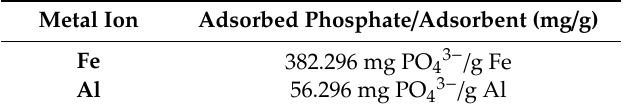
Table 3. Illustration of the amount of adsorbed phosphate on di ff erent metal compounds of adsorbent in mg / g.